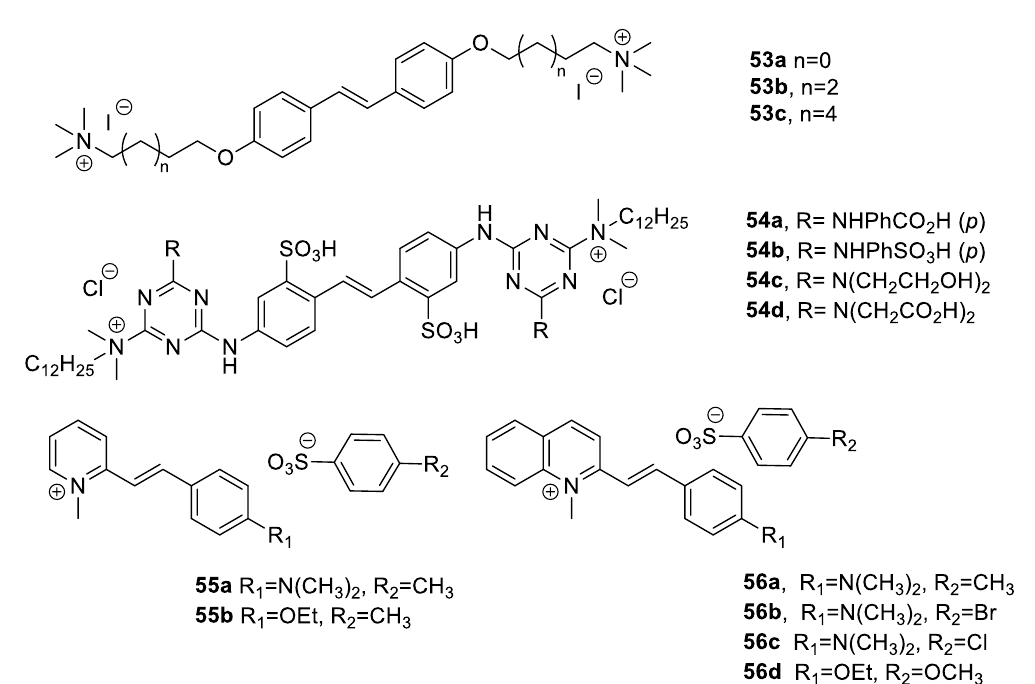
Figure 14. Chemical structures of ammonium salt-containing stilbenes from Zhou et al. (2018), Wan et al. (2017), and Chanawanno et al. (2010) [92 – 94].